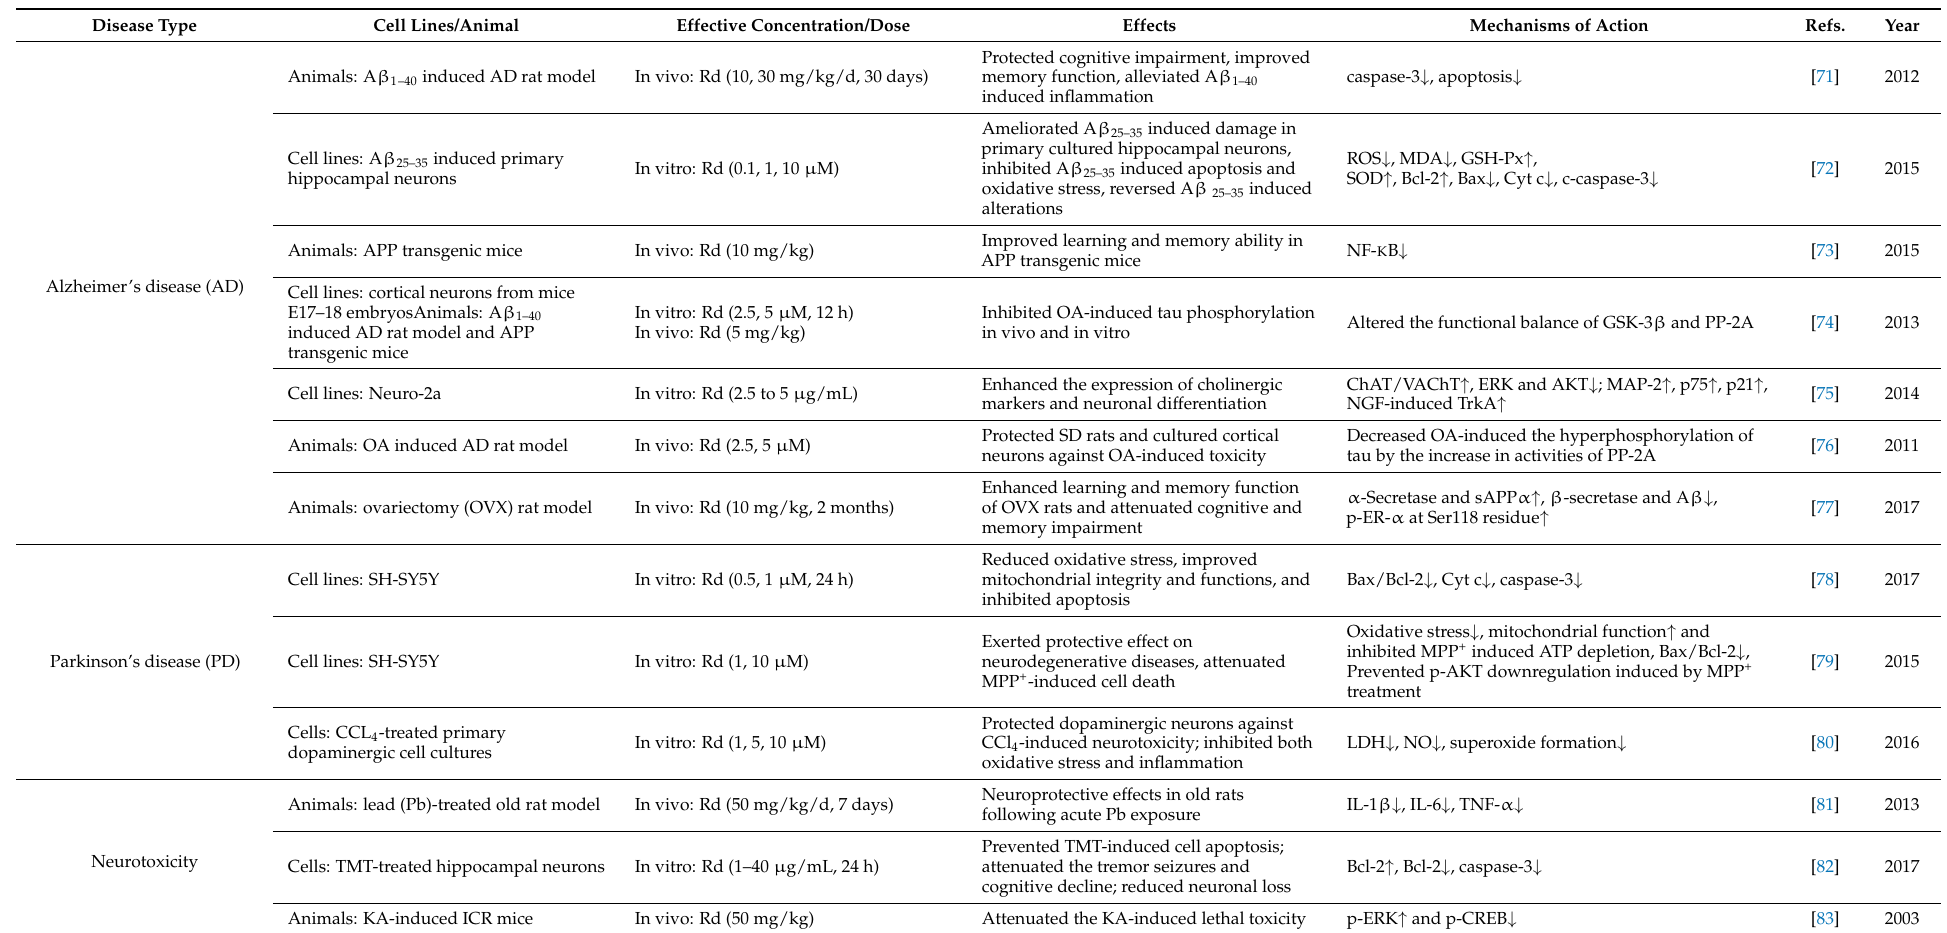
Table 4. Neuroprotective effects and the molecular mechanisms of